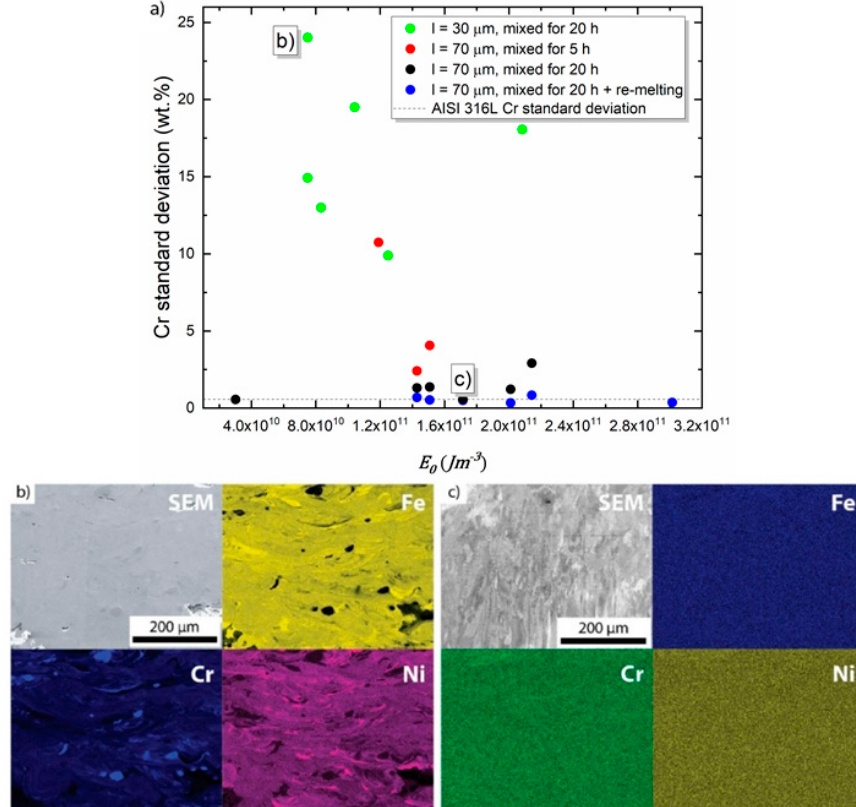
Figure 3. ( a ) Standard deviation of the Cr content from di ff erent process parameters as a function of E o . EDS elemental maps from the samples from Figure 2b ( b ) and Figure 2c ( c ). High Ni and Fe inhomogeneity, and unmelted Cr particles are observed for the low E o sample (b). Sample parameters for (b) are Q = 360 W, v = 2 m / s, h = 80 µ m, l = 30 µ m, and r b = 45 µ m. Full chemical homogeneity at this length scale was observed for intermediate E o and re-melting scan sample (c). Sample parameters for (c) are Q = 360 W, v = 0.25 m / s, h = 120 µ m, l = 70 µ m, and r b = 100 µ m. Building direction is upward for all images.